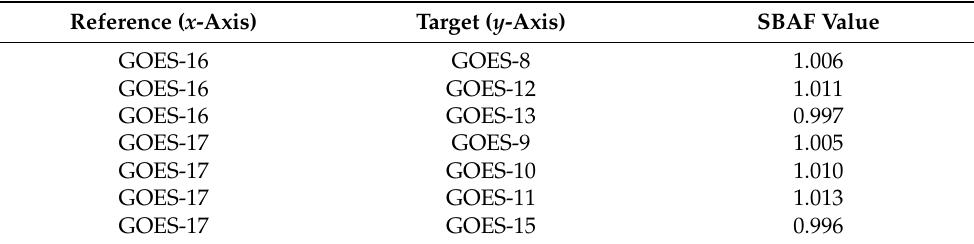
Table 3. Spectral-band adjustment factors ( SBAFs ) used in this study [20]. Reference ( x